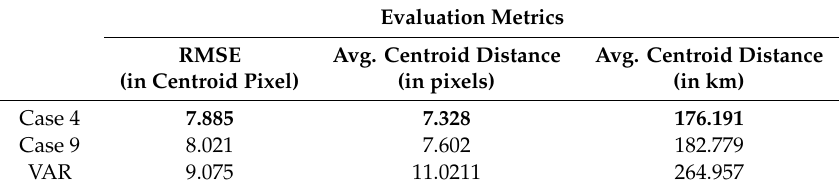
Table 10. Comparison results of Case 5, Case 10 and VAR.